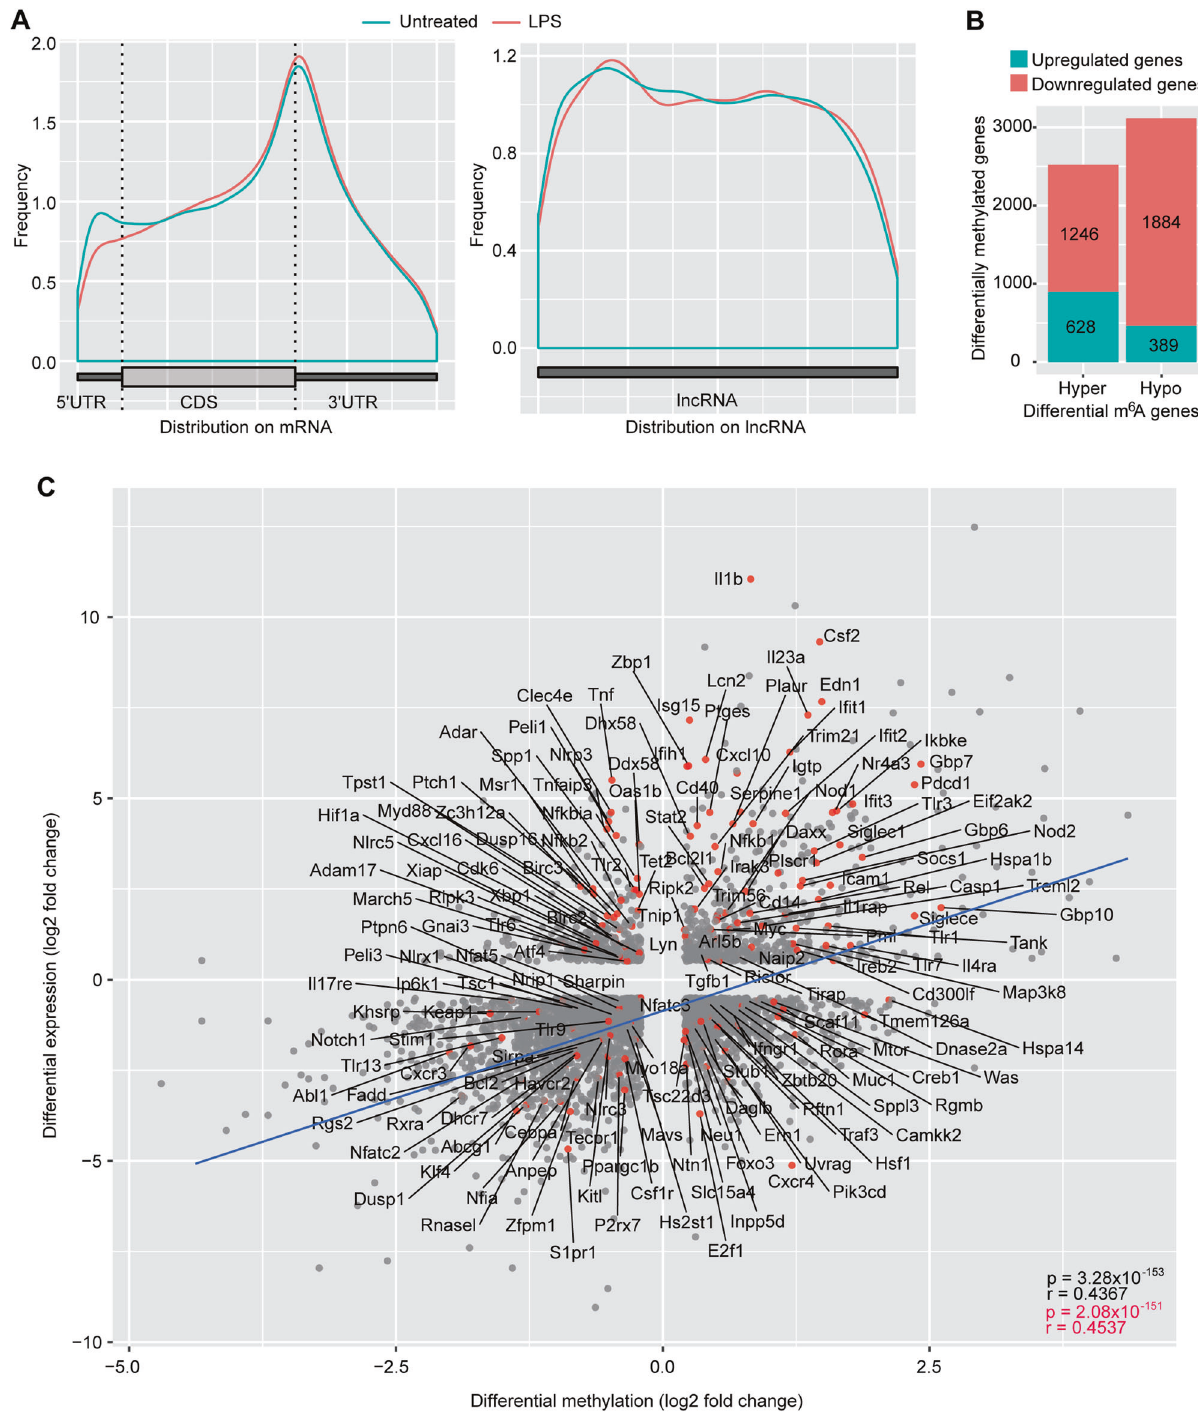
Fig. 2 LPS treatment alters cellular transcriptome and m 6 A epitranscriptome. A Overall m 6 A distribution on cellular mRNA and lncRNA following LPS treatment for 6 h. B Number of differentially expressed genes with hypermethylation and hypomethylation following LPS treatment for 6 h. C Correlation of mRNA expression level and m 6 A level for differentially expressed and methylated genes following LPS treatment. The regression lines are marked in “ blue ” . Innate immune related genes are marked with “ red dots ” .